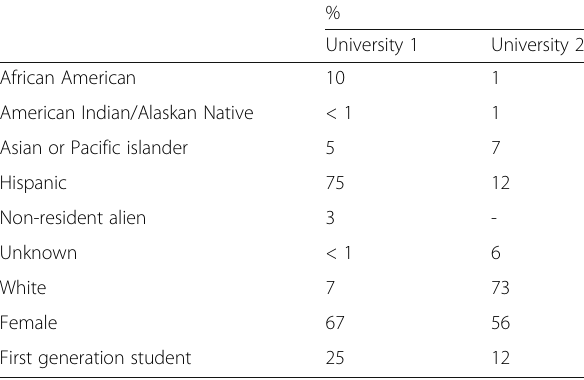
Table 2 Demographic information about the entering